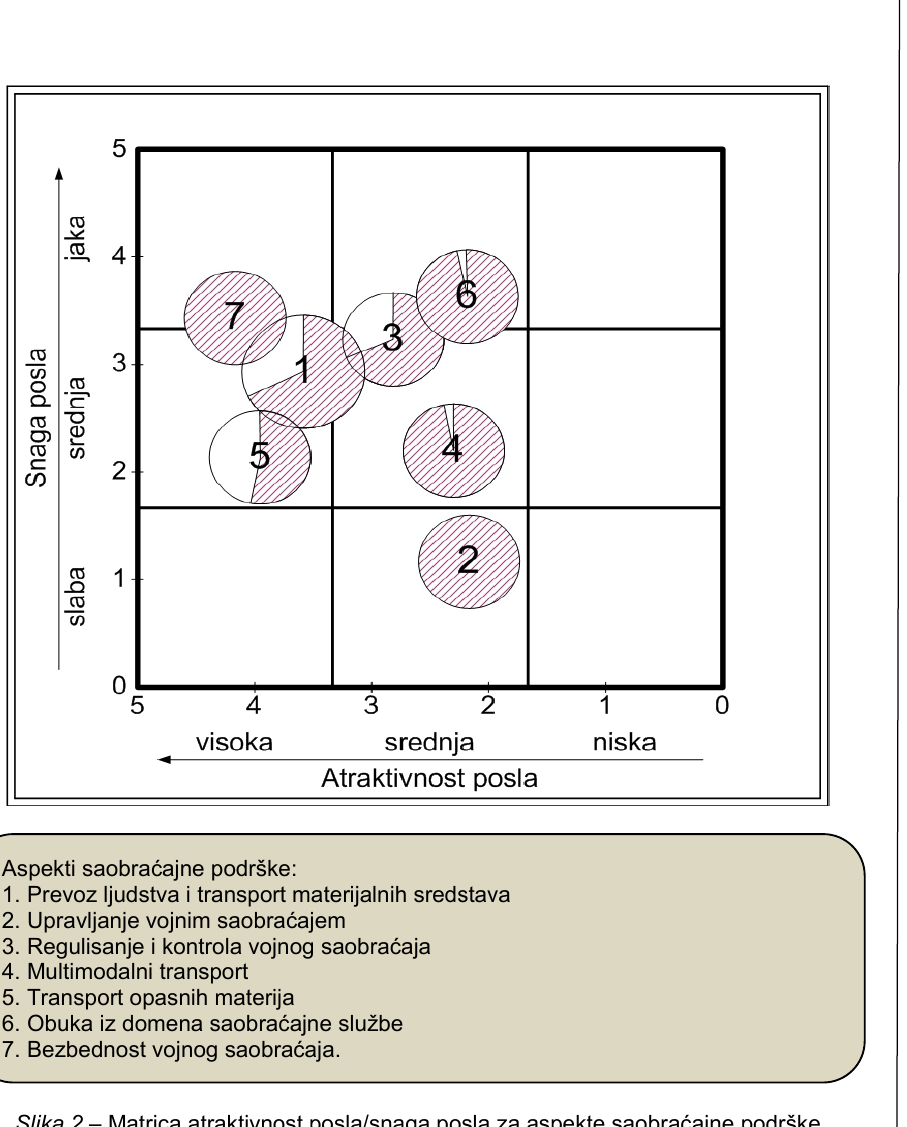
Figure 2 – Job atractivity / job strenght matrix for the aspects of movement and transportation service (Curent positions of the movement and transportation service jobs in the Army of